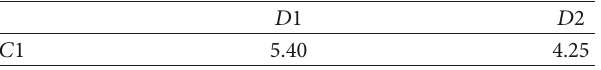
Table 4: Exponential mean cost from B1 and B2 to D1 and D2 (in $). D 1 Table 5: Exponential mean cost from C1 to D1 and D2 (in $). D 1 D 2